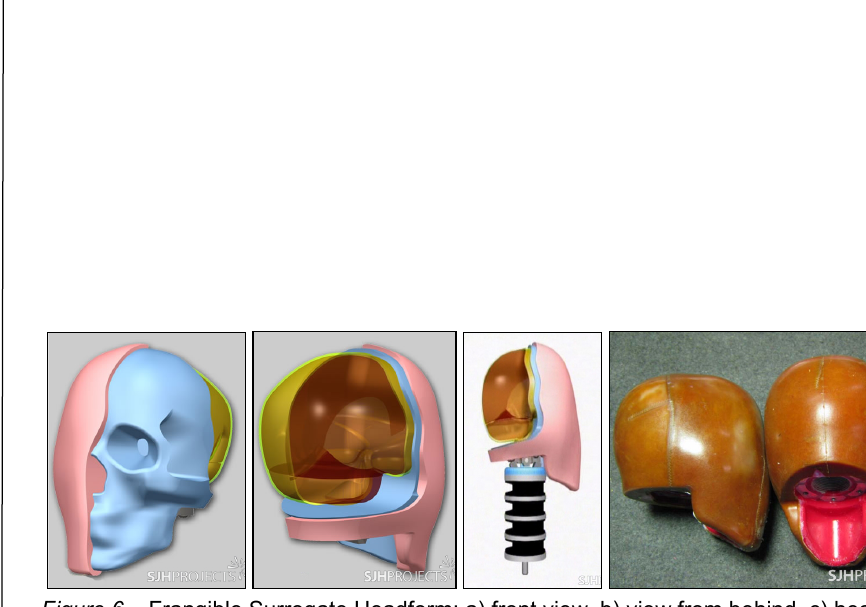
Figure 6 – Frangible Surrogate Headform: a) front view, b) view from behind, c) head on the neck of the Hybrid III dummy, d) Completed Frangible Surrogate Headform Рис . 6 – Голова антропометрического манекена : а ) вид спереди , б ) вид сзади , с